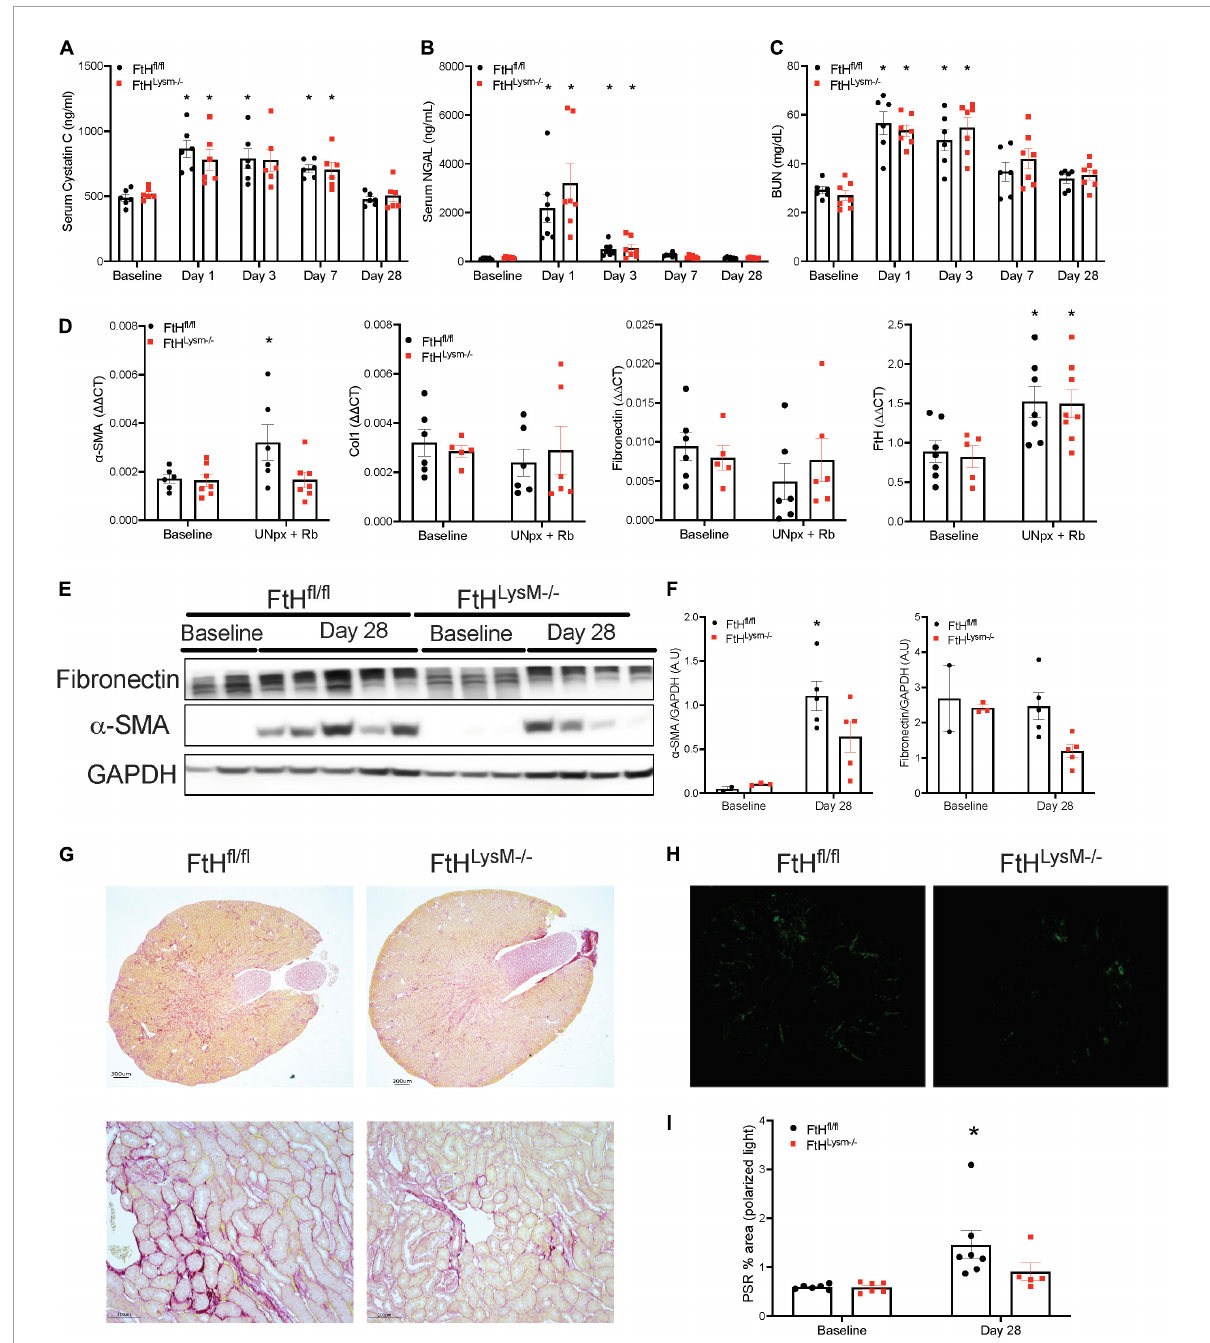
FIGURE7 Unilateral nephrectomy followed by rhabdomyolysis leads to AKI and kidney fibrosis. Mice were subjected to unilateral nephrectomy followed by administration of 7.5 ml/kg body weight of 50% glycerol in water and harvested after 28 days. Blood was collected at various timepoints via facial vein and serum was analyzed for (A) cystatin C expressed in nanograms per milliliter (ng/ml), (B) neutrophil gelatinase associated lipocalin (NGAL) expressed in ng/ml, (C) BUN expressed in milligrams per deciliter (mg/dl). All data are expressed as mean ± SEM. * p < 0.05 vs. baseline. (D) Kidneys were analyzed for the expression of α -smooth muscle actin, collagen 1, fibronectin, FtH by real-time PCR analysis. Results were normalized to GAPDH and presented as mean ± SEM. * p < 0.05 vs. baseline control; # p < 0.05 vs. FtH fl / fl . (E) Whole kidney lysates were analyzed for the expression of fibronectin and α -smooth muscle actin by western blot analysis. (F) Expression of the indicated proteins in the kidneys was analyzed by densitometry, normalized to GAPDH and expressed as mean ± SEM. * p < 0.05 vs. baseline control. (G) Representative images of the Picrosirius stained kidney sections are shown. Scale bar represents 300 and 100 µ m. (H) Representative images of the stained kidney sections under polarized light are shown. (I) Collagen deposition was quantified under polarized light and data are expressed as percent area. ∗ p < 0.05 vs.